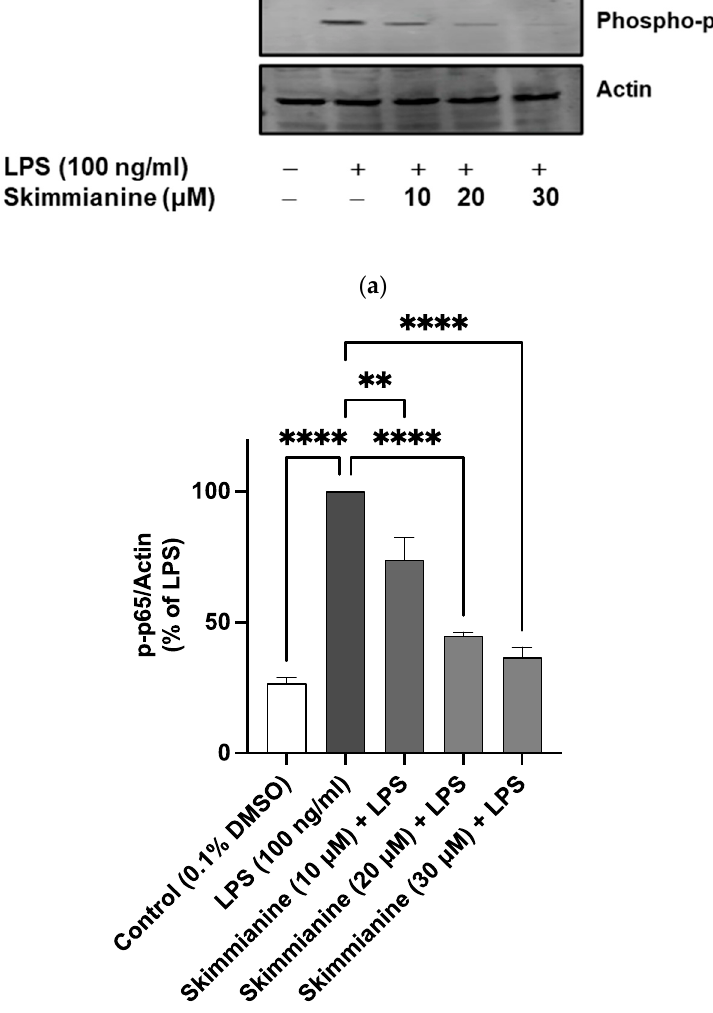
Figure 8. Skimmianine inhibits the nuclear translocation of p65/NF- κ in BV-2 microglia stimulated with LPS. BV-2 cells were stimulated with LPS (100 ng/mL) in the presence or absence of skimmianine (10, 20 and 30 μ M) for 60 min. At the end of the incubation, cell lysates were analysed with western blotting ( a ). Densitometric analyses of the membranes were performed with Image J software ( b ). Values are mean ± SEM of at least three independent experiments. A statistical analysis was carried out using a one-way ANOVA with a post hoc Dunnett’s test. ** p < 0.05; **** p < 0.0001 in comparison with LPS stimulation.